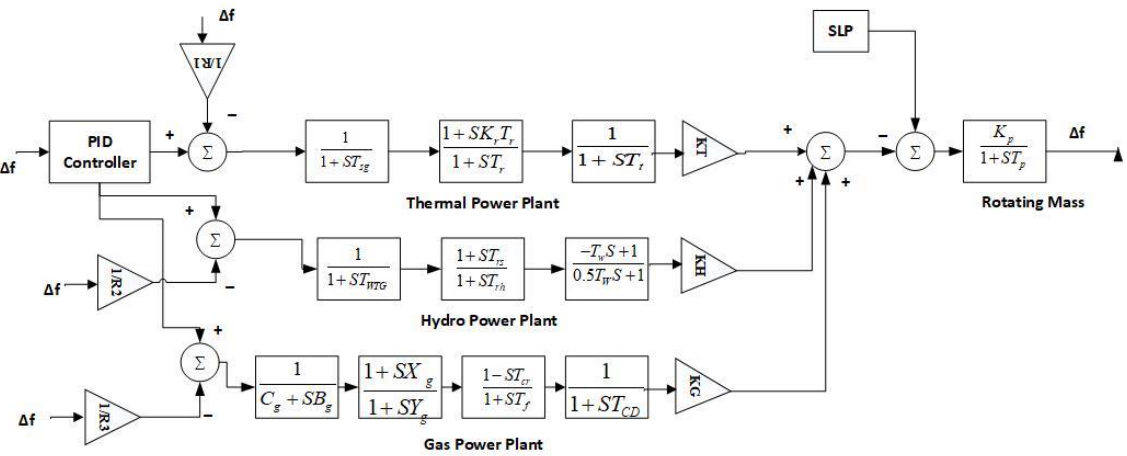
Figure 1. Mathematical model of the proposed system.